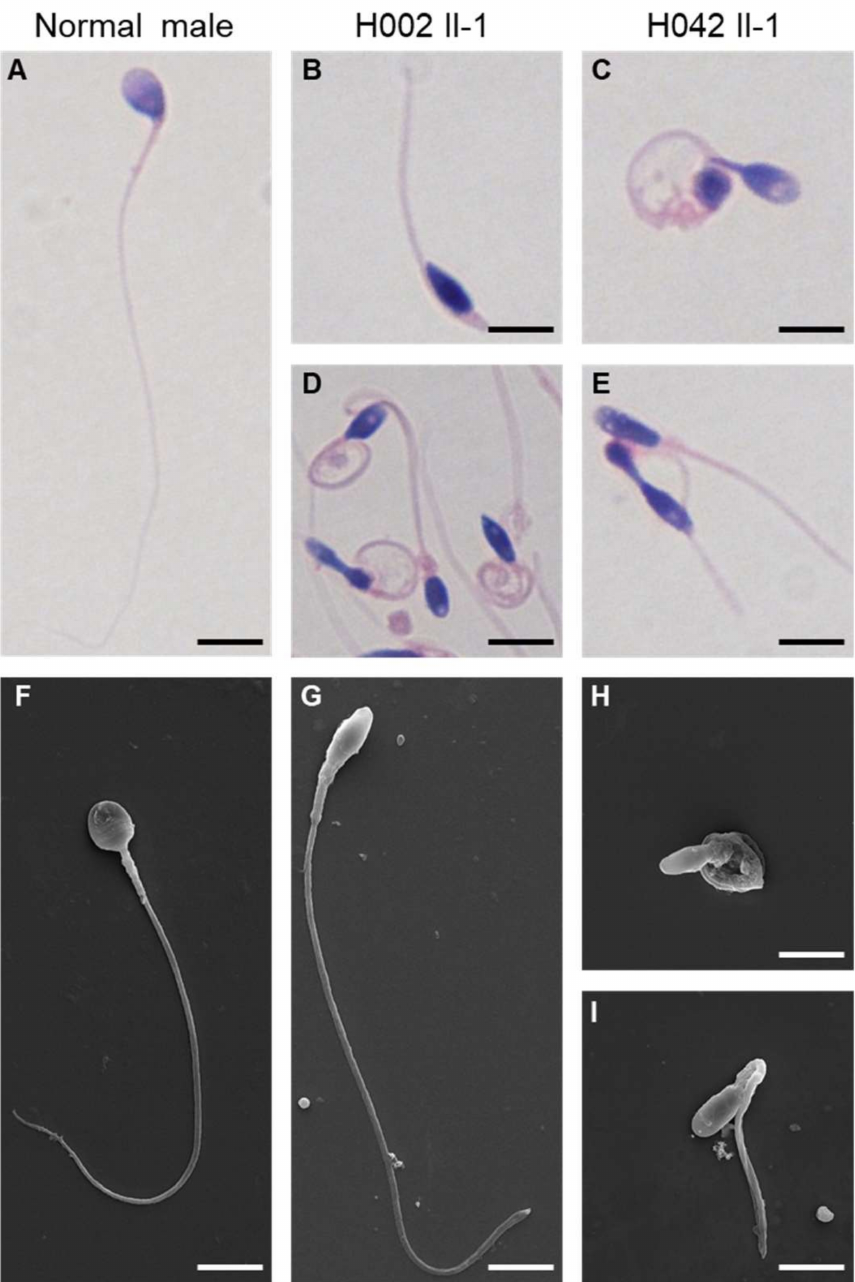
Figure 5. Sperm morphology analyses for men harboring hemizygous USP26 variants. Normal morphology of the spermatozoon from a healthy control male, as revealed by light microscopy ( A ) and scanning electronic microscopy ( F ). For the spermatozoa from men harboring hemizygous USP26 variants, multiple malformations were observed, including short ( B , I ) and coiled flagella ( C , D , H ), and thin heads ( D , E , G – I ). Scale bars: 5